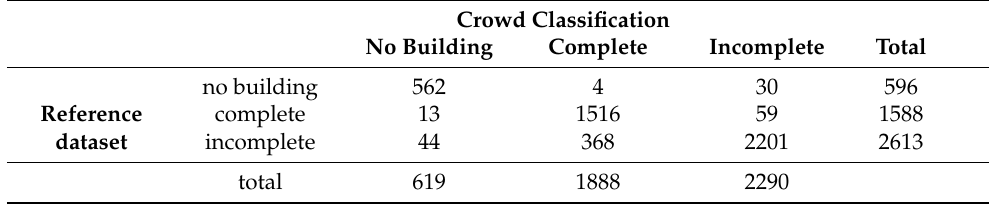
Table 4. Confusion matrix of the completeness classification